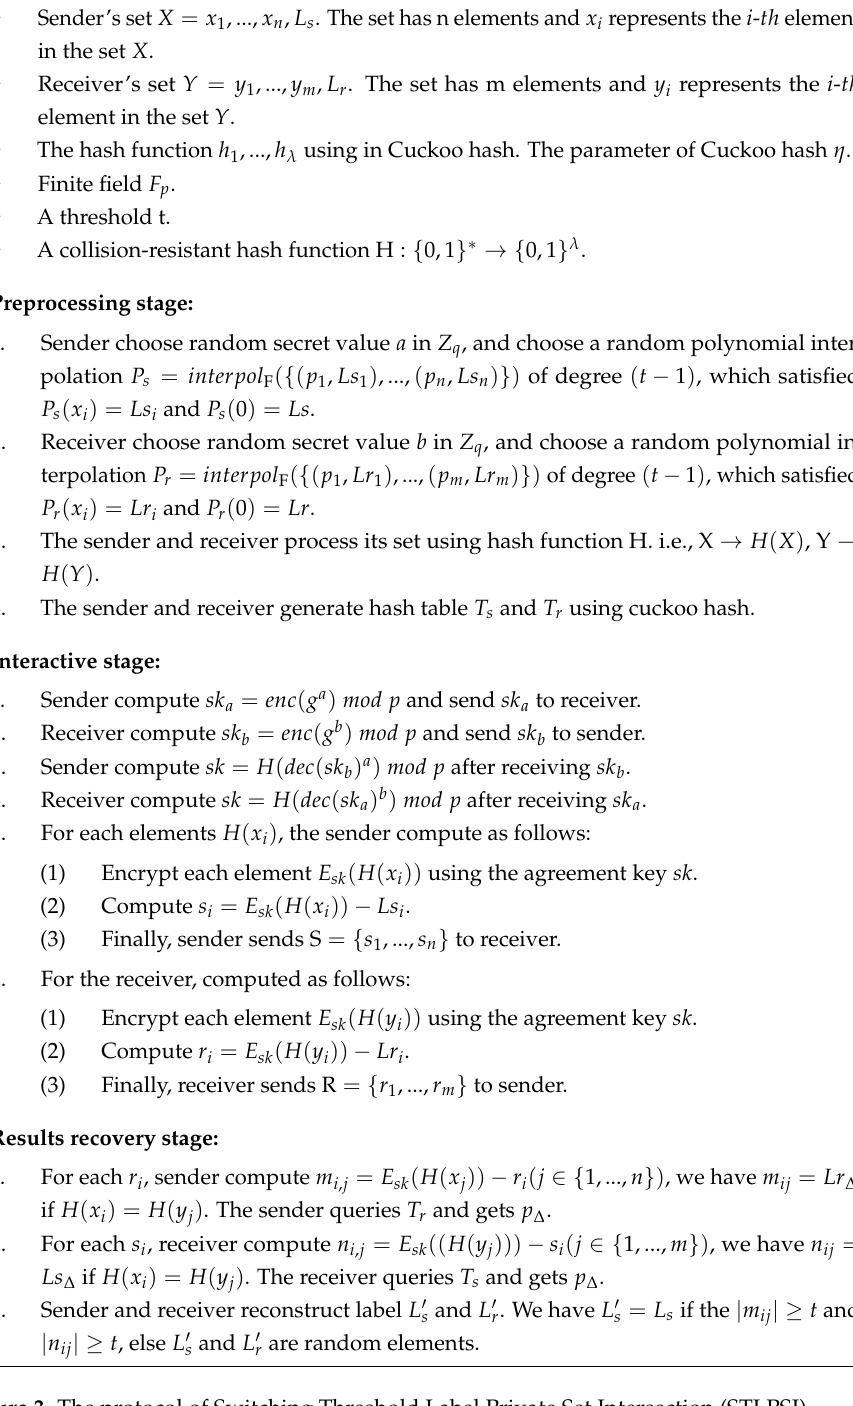
Figure 3. The protocol of Switching Threshold Label Private Set Intersection (STLPSI)